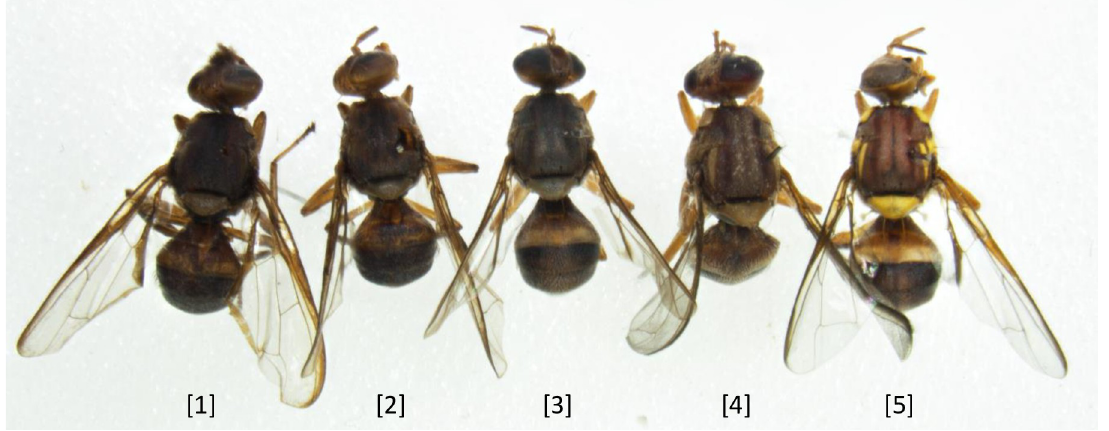
Fig 2. Examples of numerical scale used in scoring damage caused to dacine fruit fly characters by lysis buffers trialled in this study, using B . tryoni as an example. The fly on the far right-hand side was untreated, i.e., score 5, while the four flies to the left of this were treated resulting in damage scores of 1 to 4, in order from left to